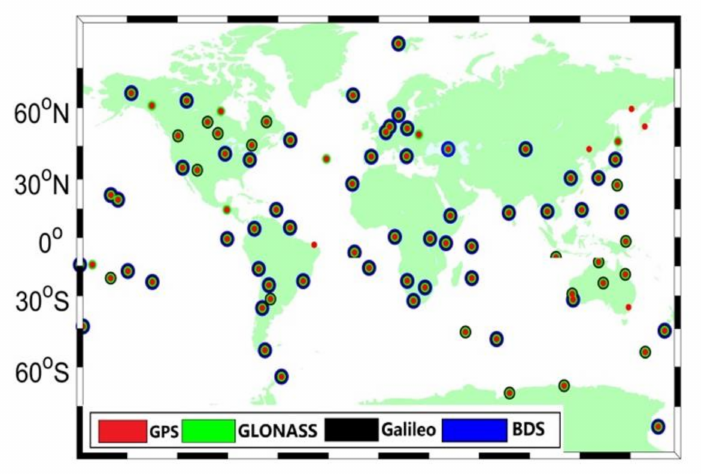
Figure 2. Distribution of real-time GNSS stations in NTSC time and frequency transfer prototype system for products